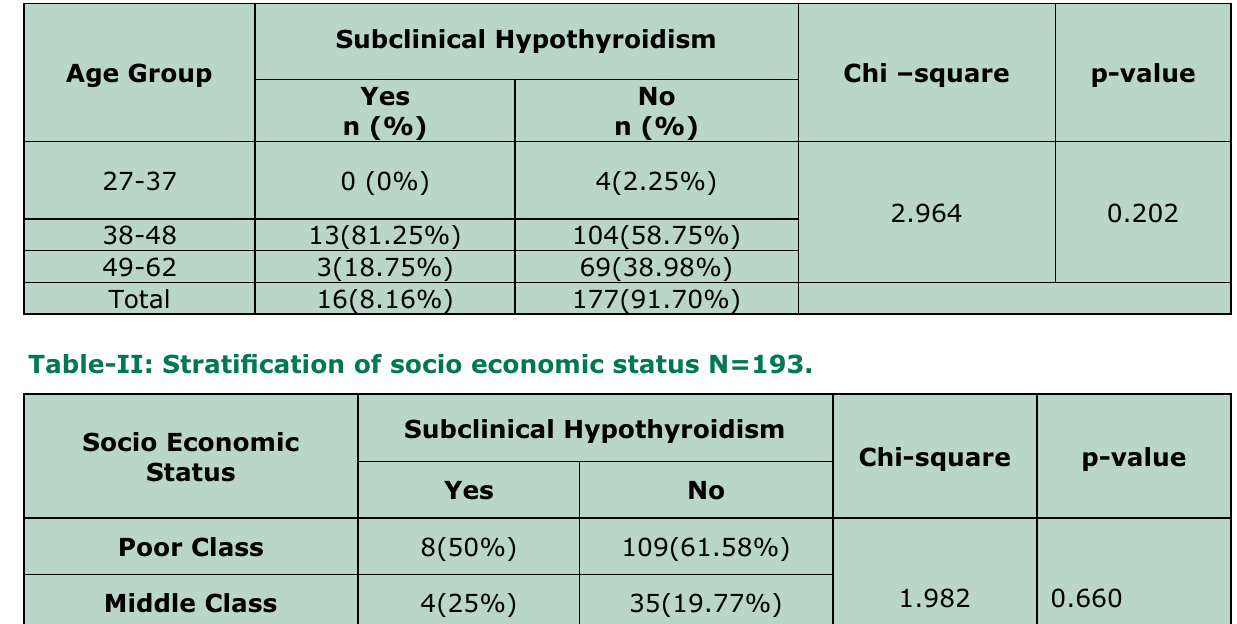
Table-I: Age Distribution N=193.